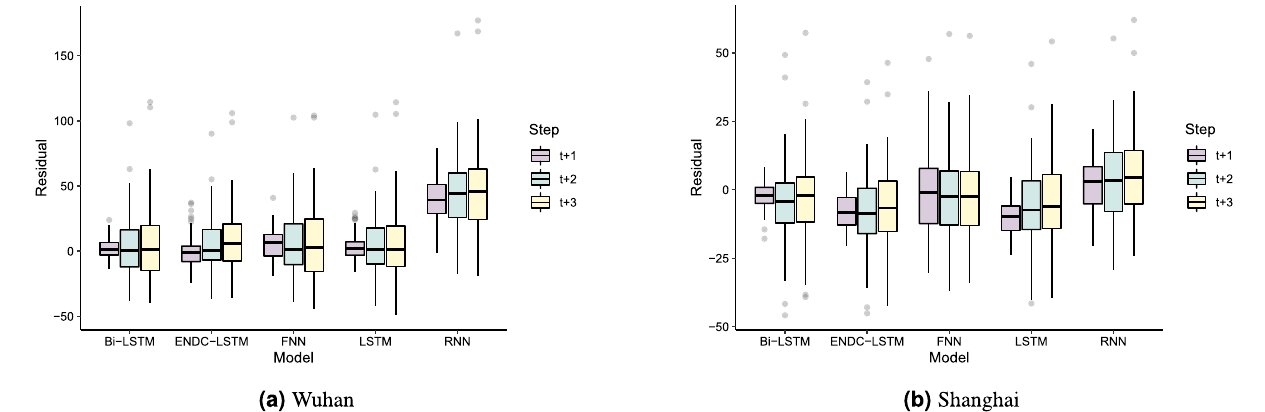
Figure 10. The residuals of the proposed model and other